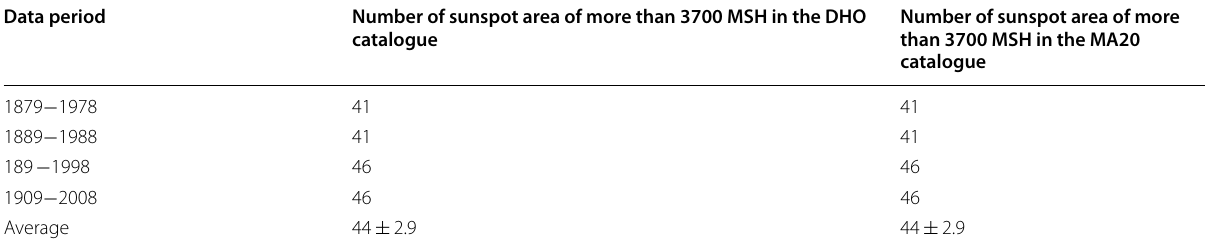
Table 3 Number of sunspot area more than 3700 MSH for 100-year periods in the DHO and MA20 catalogues Data